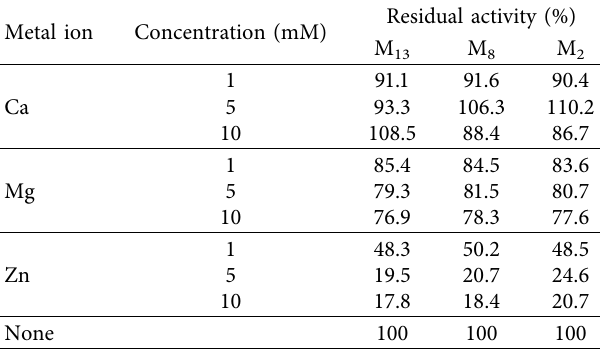
Table 4: The effect of metal divalent cations on crude amylase from the three isolates. Each value represents the mean of three inde- pendent